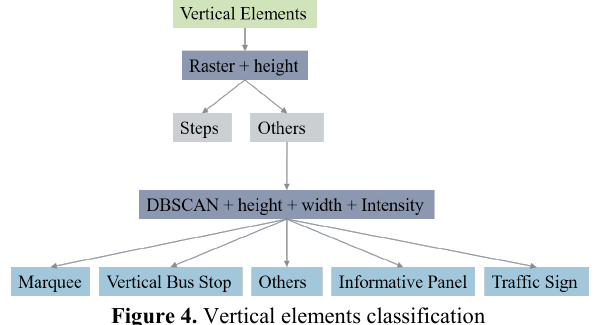
Figure 4. Vertical elements classification